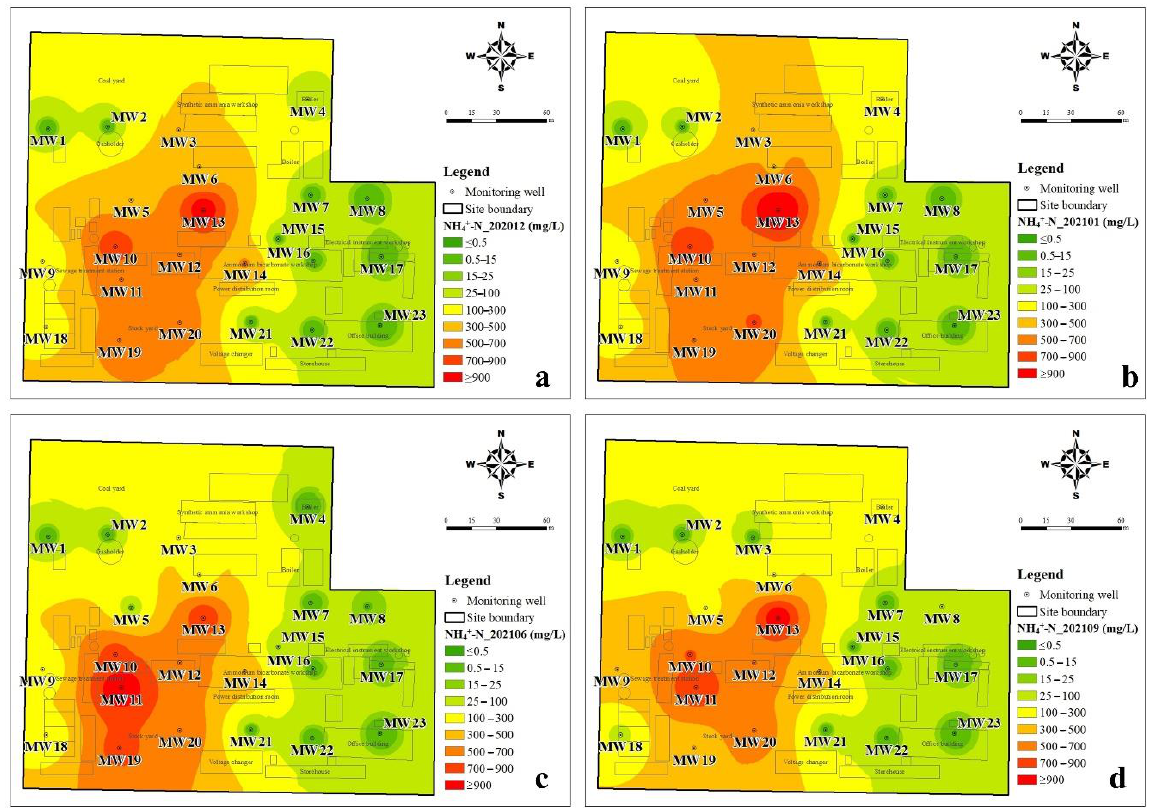
Figure 4. Interpolation diagram of ammonia-nitrogen in groundwater ( a ): in December 2020, ( b ): in January 2021, ( c ): in June 2021, ( d ): in September 2021.